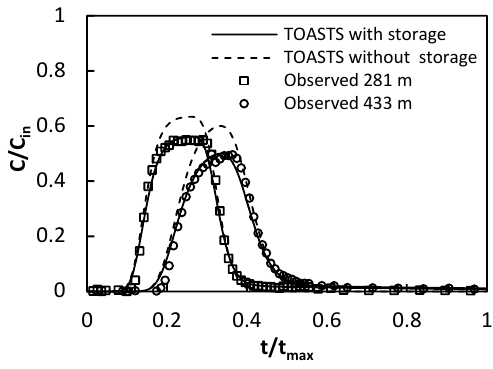
Figure 14. The TOASTS model results for simulation with and without transient storage (test case 3).